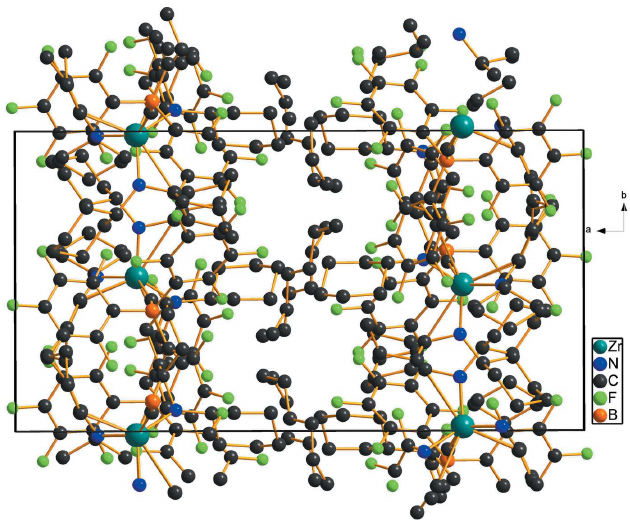
Figure 3 A view along the c axis showing the packing of molecules in the crystal structure of compound 1 and n -hexane. No significant supramolecular features can be observed. Color code: C grey, H white, B orange, F bright- green, N blue, Zr dark-green spheres.